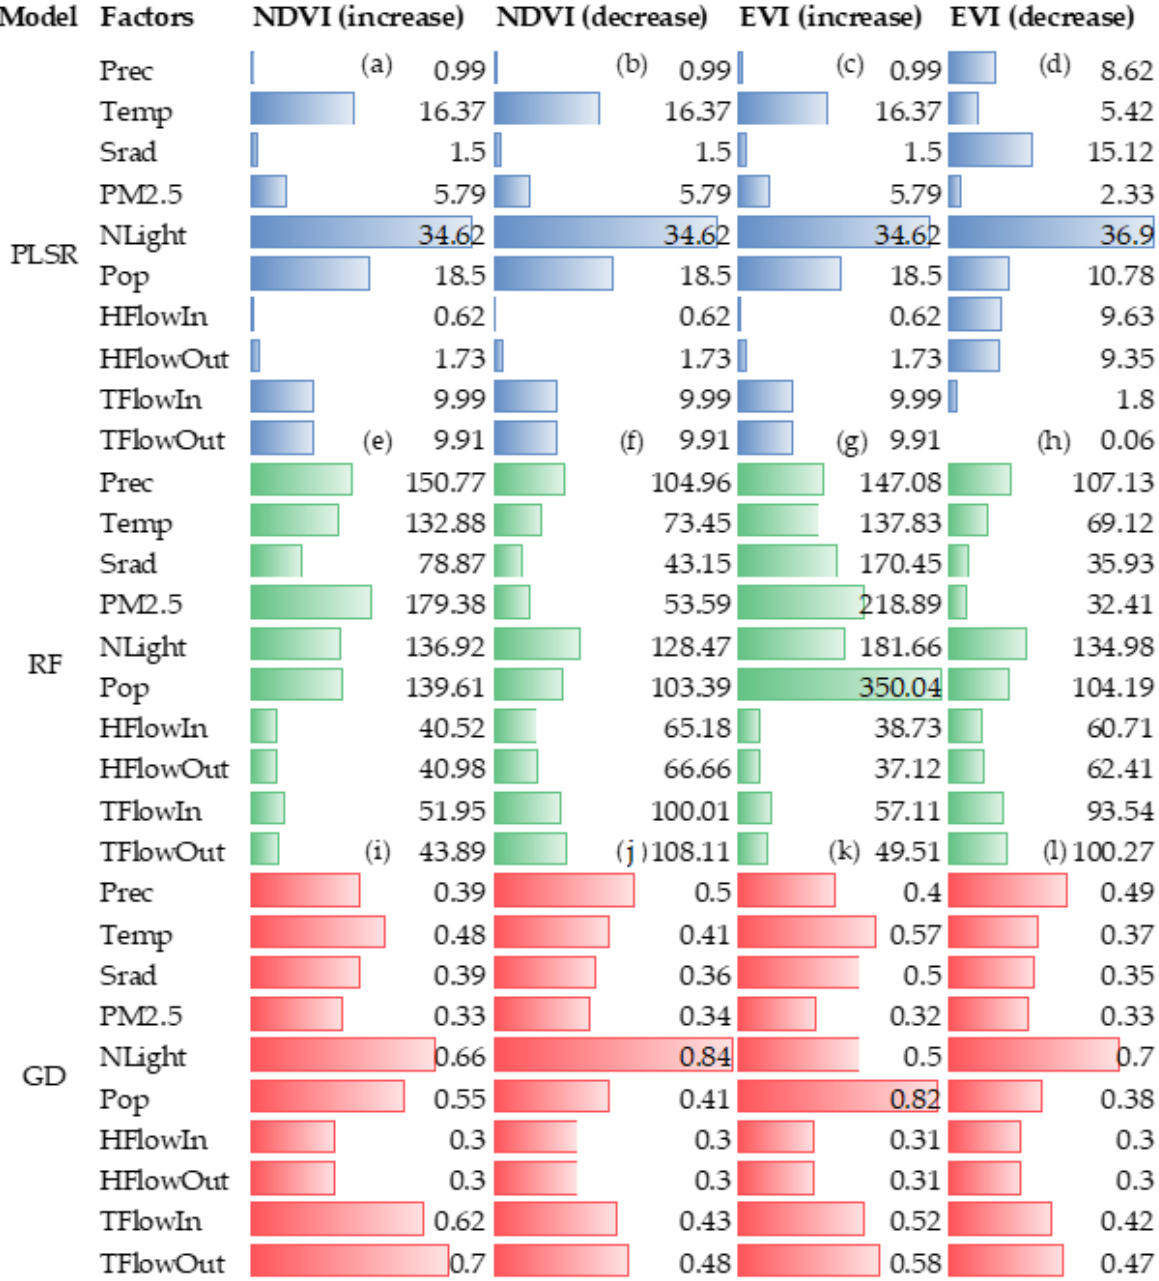
Figure 7. The importance score of driving factors to vegetation change based on partial least squares regression, random forest, and geographical detector methods. ( a , e , i ) were the important score of impact factors in NDVI increase change based on partial least squares regression, random forest, and geographical detector, respectively. ( b , f , j ) were the important score of impact factors in NDVI decrease change based on partial least squares regression, random forest, and geographical detector, respectively. ( c , g , k ) were the important score of impact factors in EVI increase change based on partial least squares regression, random forest, and geographical detector, respectively. ( d , h , l ) were the important score of impact factors in EVI decrease change based on partial least squares regression, random forest, and geographical detector,